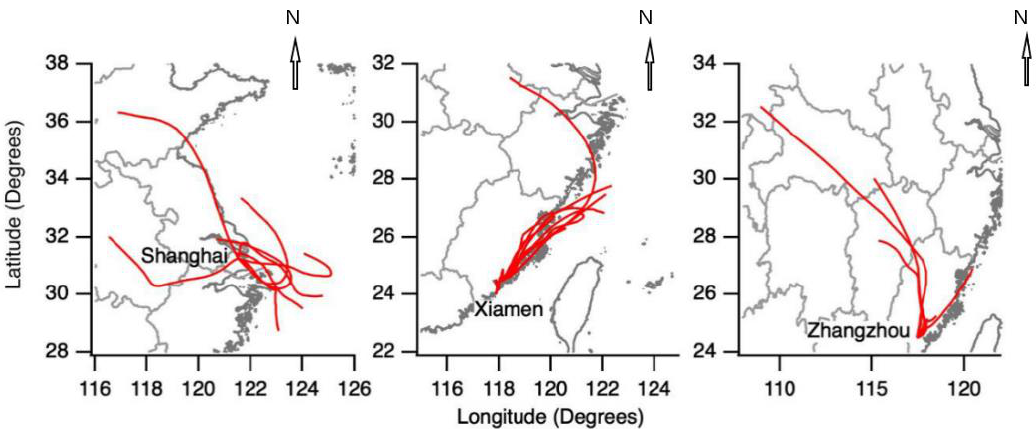
Figure 2. Twenty-four-hour air mass backward trajectories at the three sampling sites in Shanghai, Xiamen, and Zhangzhou during their respective sampling days.